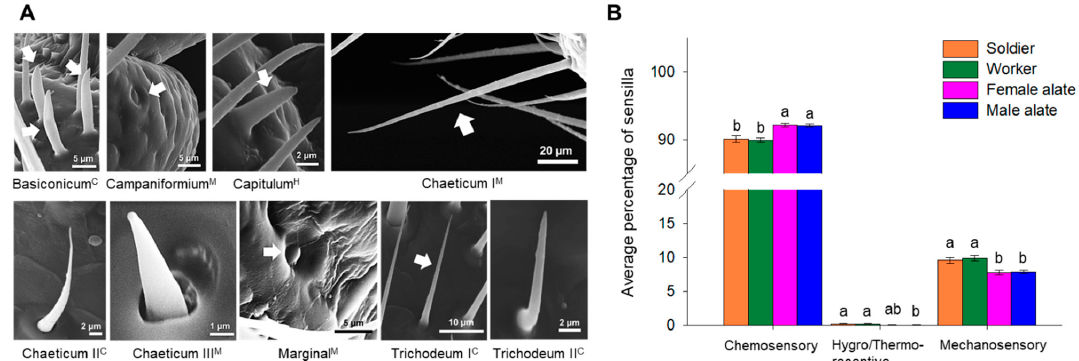
Figure 2. Morphological types of sensilla and functional categories. ( A ) Nine types of sensilla identified in all castes C putative chemosensory sensilla; H/T: putative hygro/thermoreceptive sensilla; M: putative mechanosensory sensilla). ( B ) Proportions of sensilla per functional category. Bars represent percentage of the different types of sensilla combined per functional category (mean ± SE; n = 24 for workers, n = 23 for soldiers; and n = 18 for both female and male alates). For each functional category, groups denoted with the same letter are not significantly different ( p > 0.05, Kruskal–Wallis followed by pairwise Wilcoxon rank sum tests with Bonferroni correction). Table 2. Characteristics of sensilla. Morphological measurement data (mean ± SE, n = 3) were obtained from workers. Putative functions were determined based on morphology and location of sensilla and previously published descriptions [40,41].